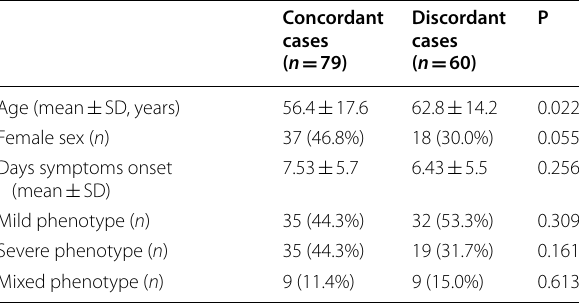
Table 1 Patients’ characteristics according to agreement between CXR readings and LUS